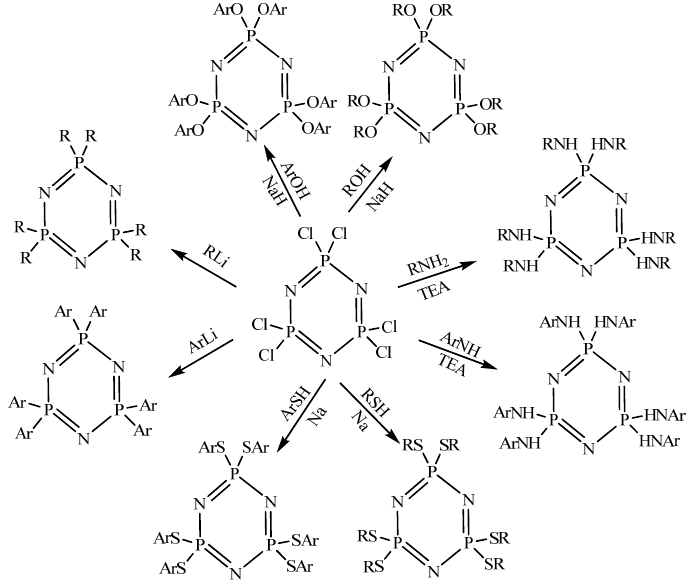
Figure 2. Synthetic schemes of the phosphazene derivatives. Taken with permission from [19,27].